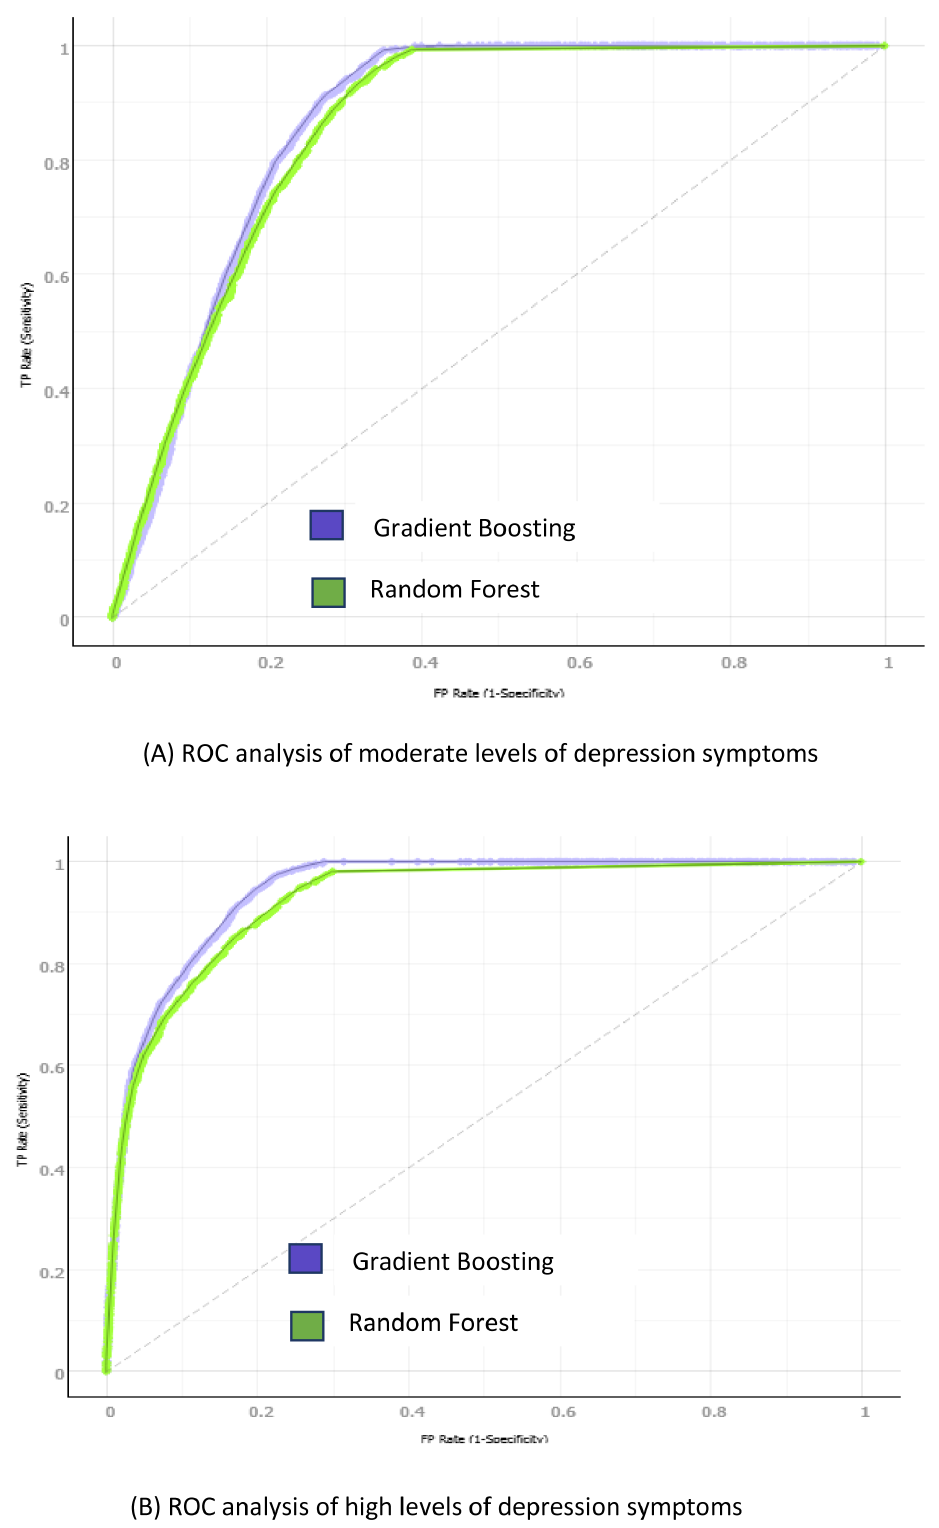
Figure 4. Gradient Boosting and Random Forest ROC sensitivity and specificity analysis: ( A ) Moderate depression symptoms analysis; ( B ) High depression symptoms